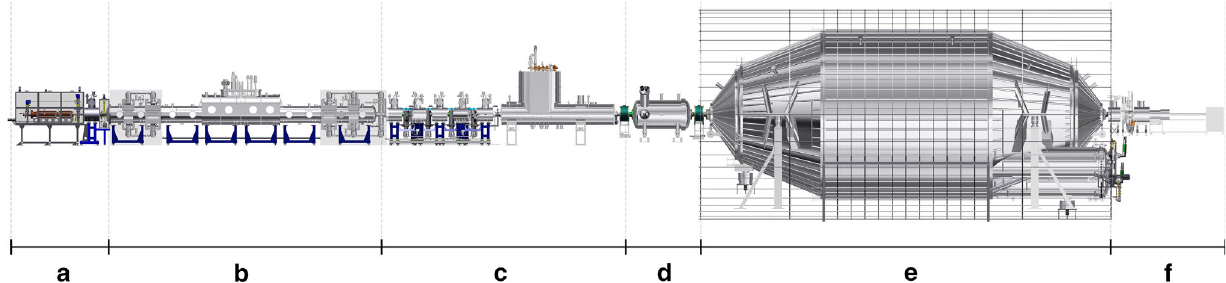
Fig. 6 The KATRIN experimental setup, 70 m in length. The monitor- ing and calibration section (a) residing at the rear of the high-luminosity windowless source (b) provides stable and precise monitoring of tritium gas properties. The transport system (c) magnetically guides the elec- trons further downstream and prevents tritiated gas from entering the